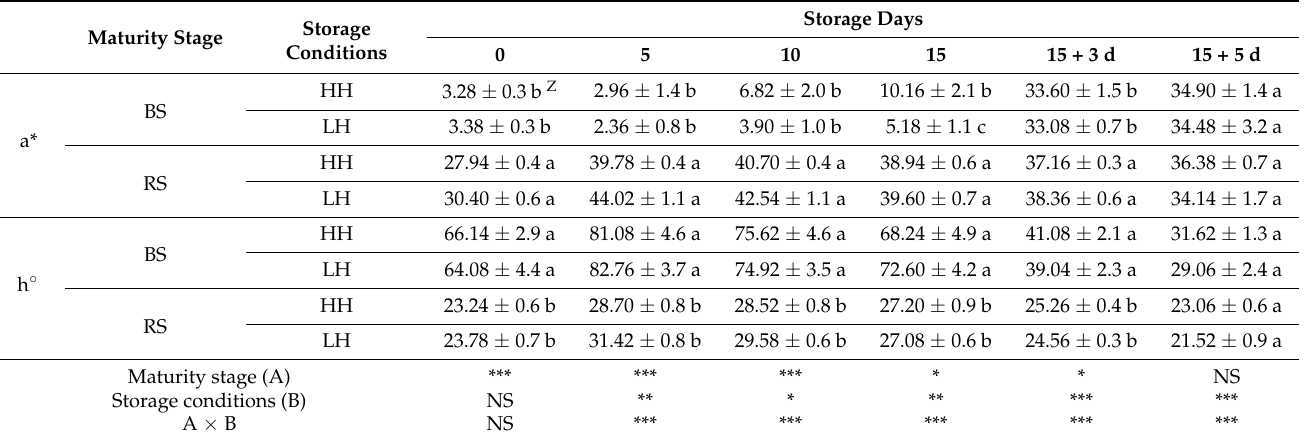
Table 3. The effect of high and low RH on sweet peppers’ a* and hue angle (h ◦ ) before, during, and after 15 days of cold storage at 5 ◦ C and 5 days at ambient